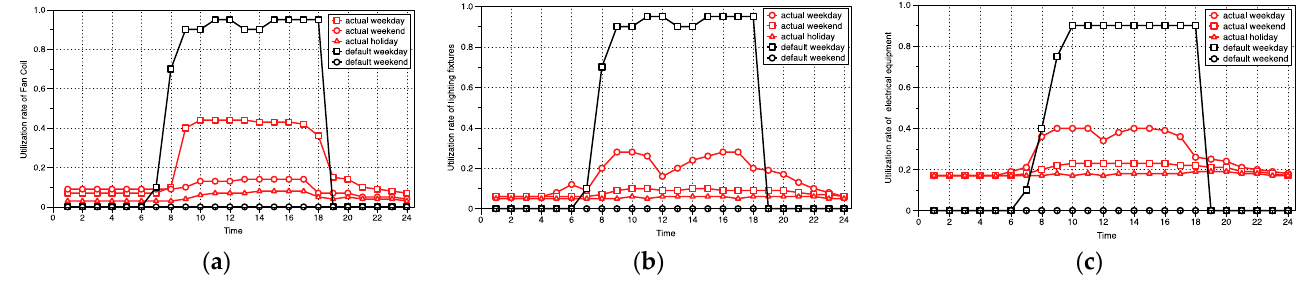
Figure 3. The setting of dynamic schedule parameters: ( a ) HVAC system and staff schedule; ( b ) Lighting schedule; ( c ) Equipment schedule.